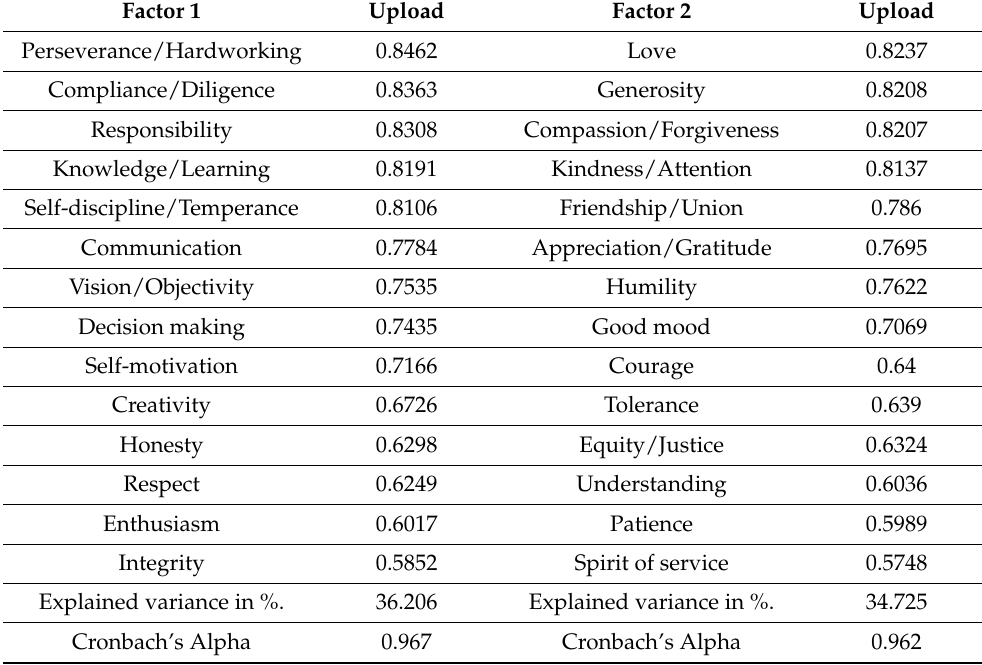
Table 16. Factor composition of the ethical values present in